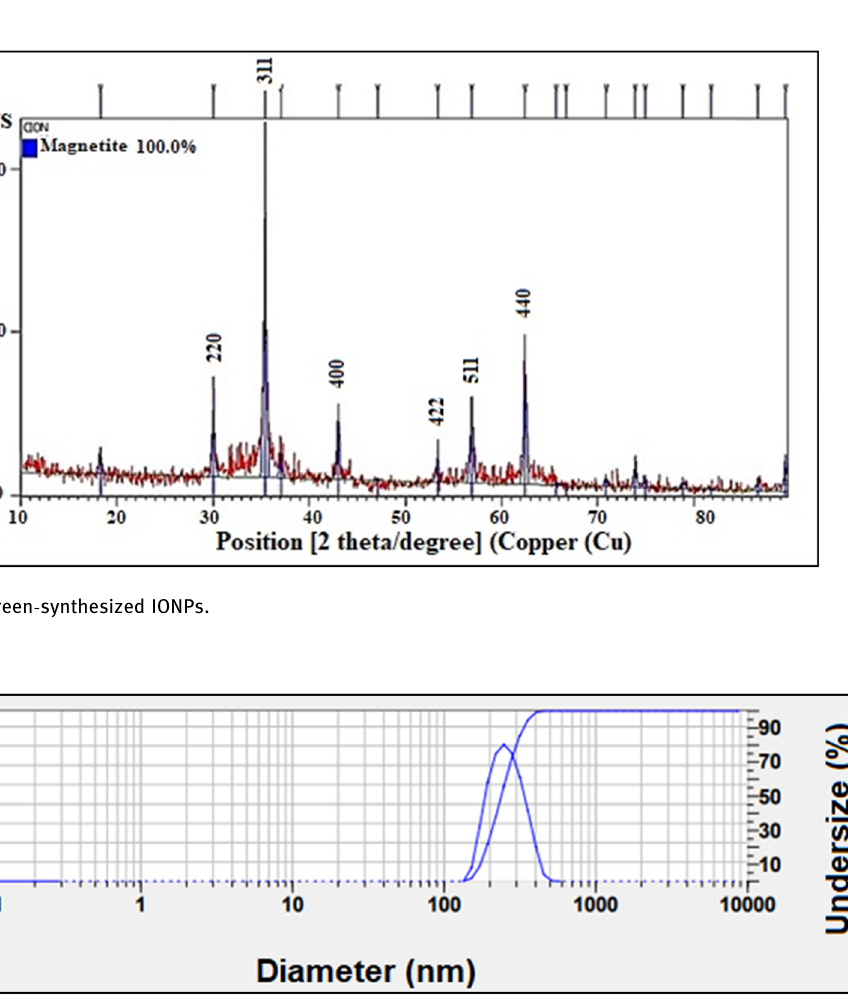
Figure 4: DLS of the particle volume distribution size of green - synthesized IONPs using HORIBA Scienti fi c Nanoparticle Analyzer SZ - 100.